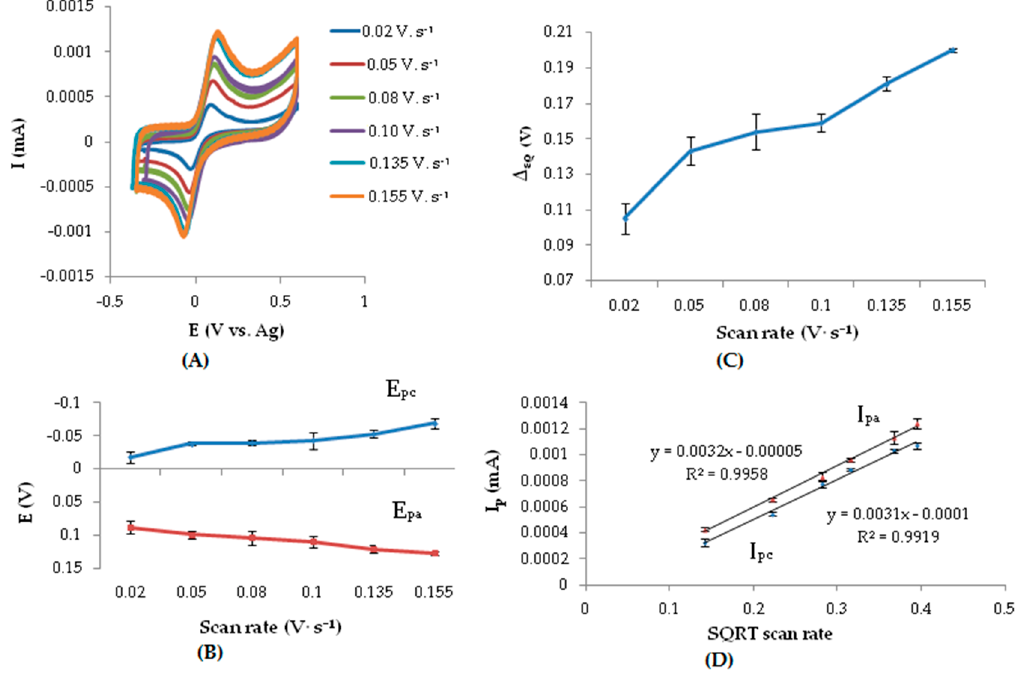
Figure 8. Scan rate investigations. ( A ) Cyclic voltammograms of DOPA from 0.02 V·s − 1 to 0.155 V·s − 1 ; ( B ) E Pc and E pa variation with scan rate; ( C ) Variation of Δ ερ with scan rate and ( D ) Linear relationship of I pa and I pc with square root (SQRT) scan rate; Not visible error bars: when the symbol size is larger than the error bar.